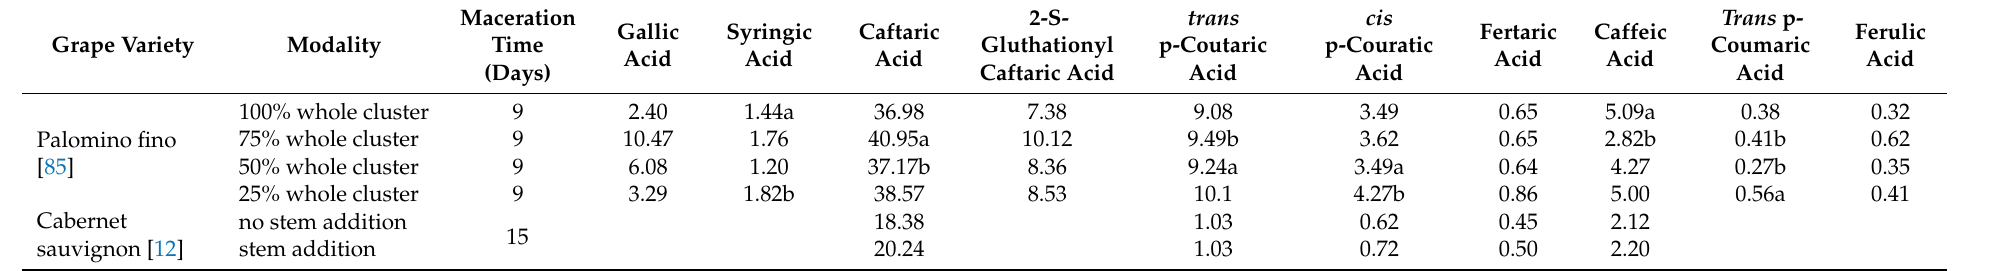
Table 16. Impact of stems on phenolic acids composition of the wine (mg/L) (for each study, different letters indicate significant statistical differences).